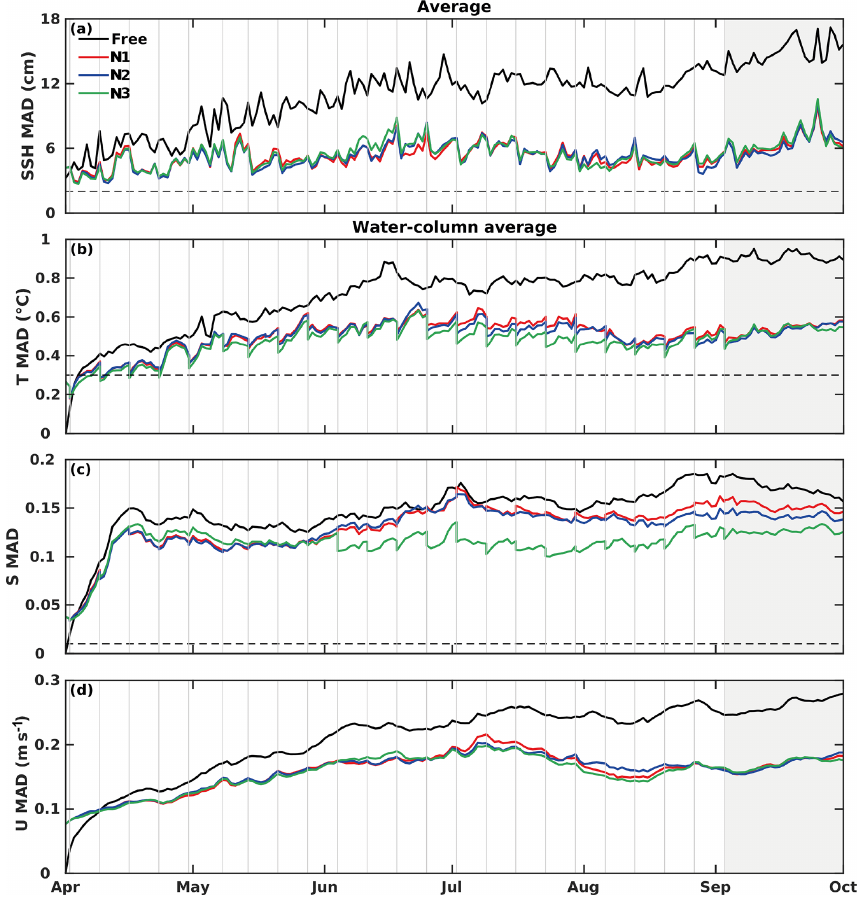
Figure 4. Time series of MAD averaged over the open gulf (excluding shelf regions shallower than 300m) for (a) SSH (cm), (b) temperature ( T , ◦ ), (c) salinity ( S ), and (d) velocity ( U , ms − 1 ) from the free run and nonidentical twin runs. The MADs of all physical variables except SSH were averaged over the entire water column. Black dashed lines in (a) , (b) , and (c) denote the values of observation errors. Gray vertical lines indicate the assimilation steps. The gray area marks the 4-week period without data